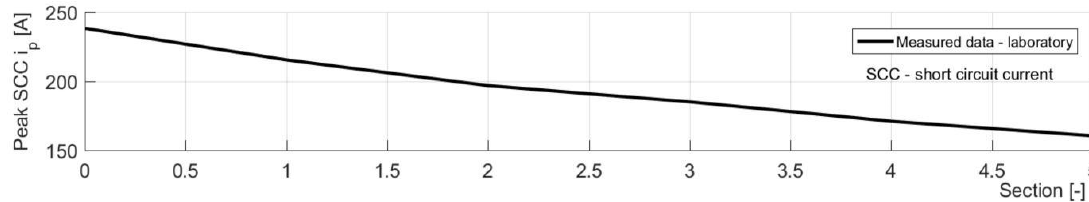
Figure 8. Measured peak of short-circuit current value. Table 6. Peak short-circuit ( i p ) and peak to peak steady-state short-circuit current (2√2𝐼 (cid:3038) = 𝐼 (cid:3038)(cid:3043)(cid:3043) ) .